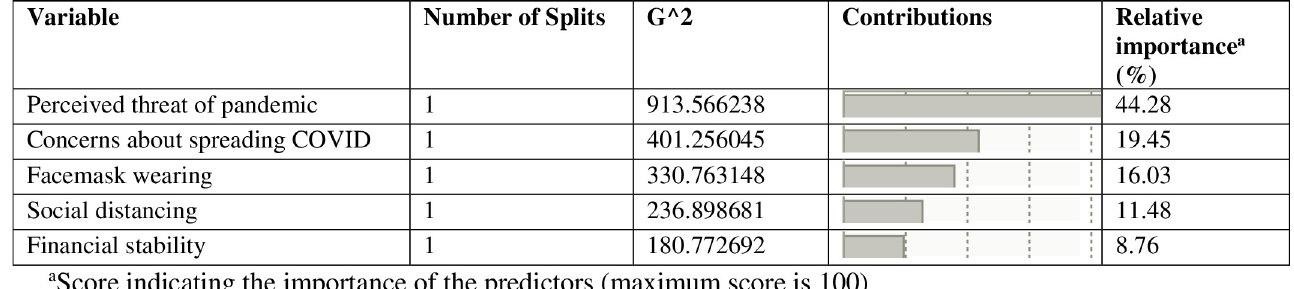
Fig 3. Column contributions of independent variables in CART